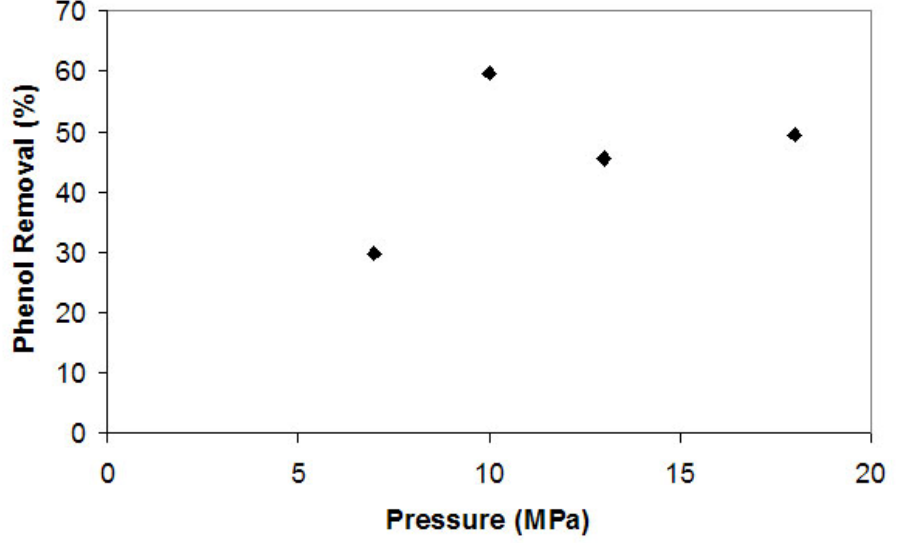
Figure 1. Phenol removal by tyrosinase in different CO